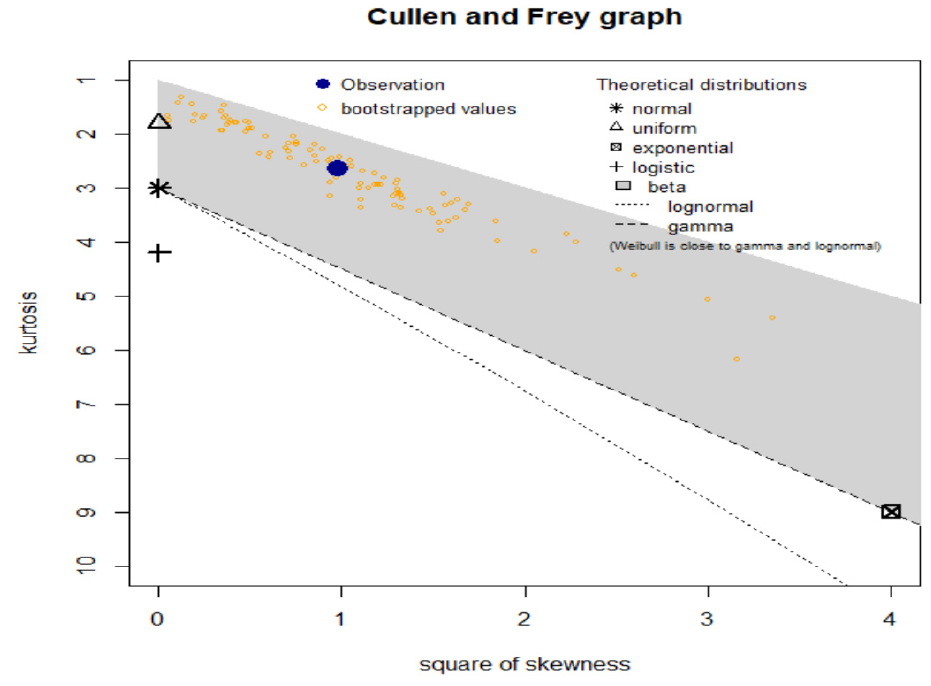
Figure 6. Cullen - Frey graph for the actuarial claims data. Figure 6. Cullen-Frey graph for the actuarial claims